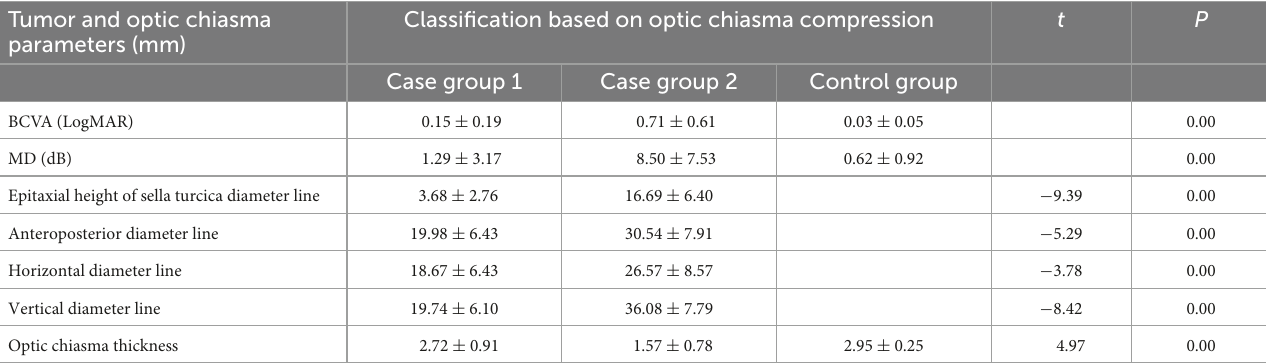
TABLE 1 Visual acuity, visual field, and tumor were compared between mild and heavy optic chiasma compression case groups. Tumor and optic chiasma parameters